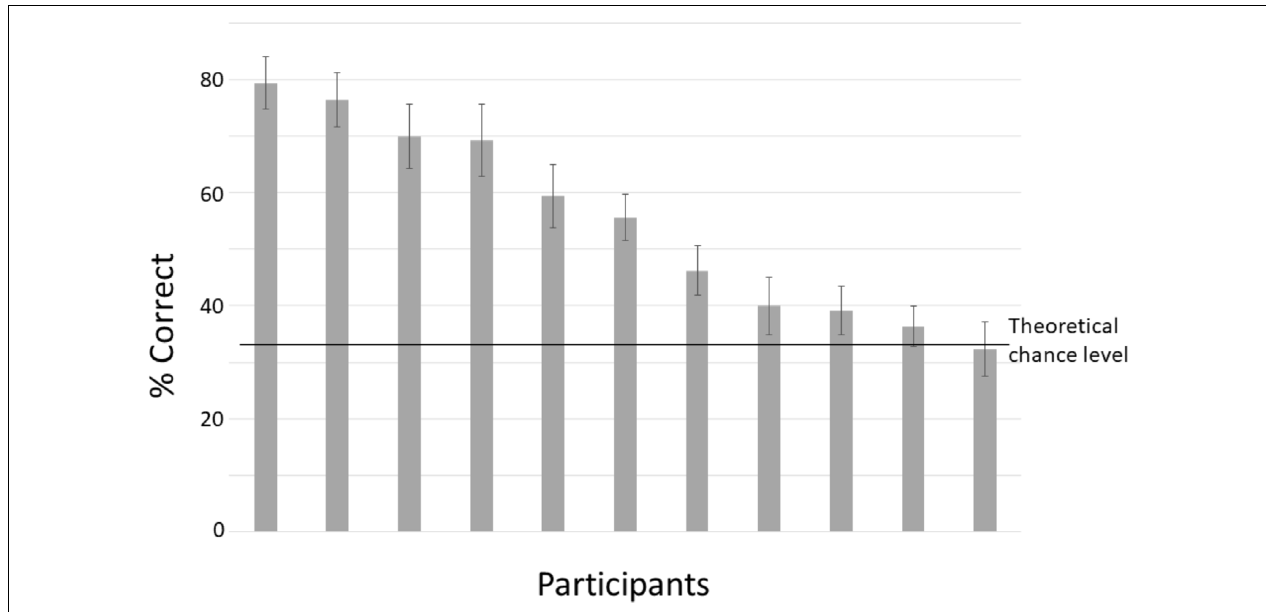
FIGURE 5 | Mean classification accuracy for the testing set, separately for each participant. Chance level is 33%. Error bars denote standard deviations.